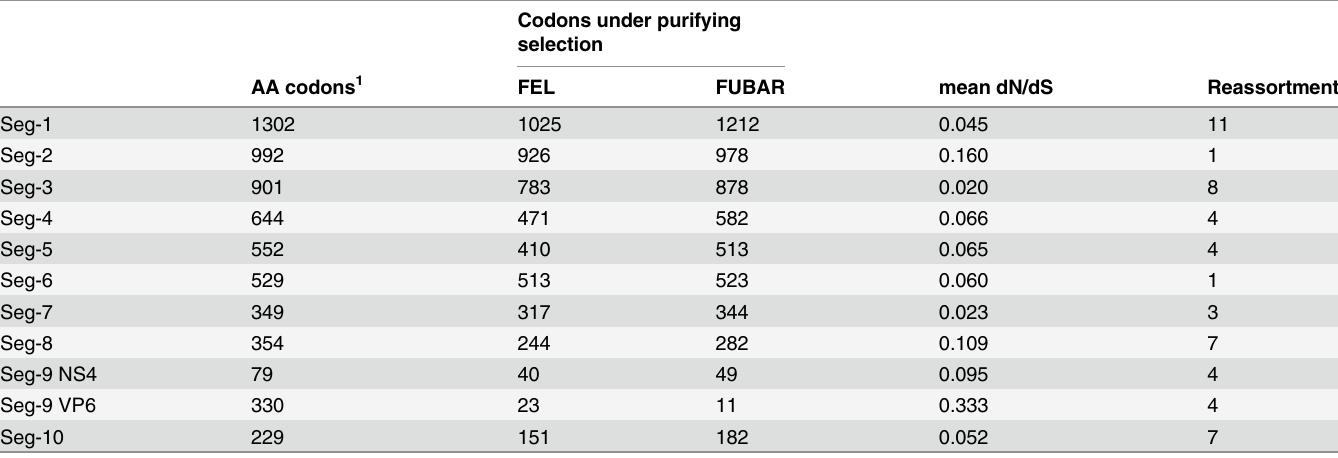
Table 2. Number of sites potentially under negative selection in the BTV genome according to two inference methods (FEL — fixed-effects likeli- hood, FUBAR — fast unconstrained Bayesian approximation). Mean dN/dS were estimated using the ‘ single likelihood ancestor counting ’ (SLAC) method. Number of reassortment events were estimated relative to Seg-2, which itself was assessed for reassortment relative to